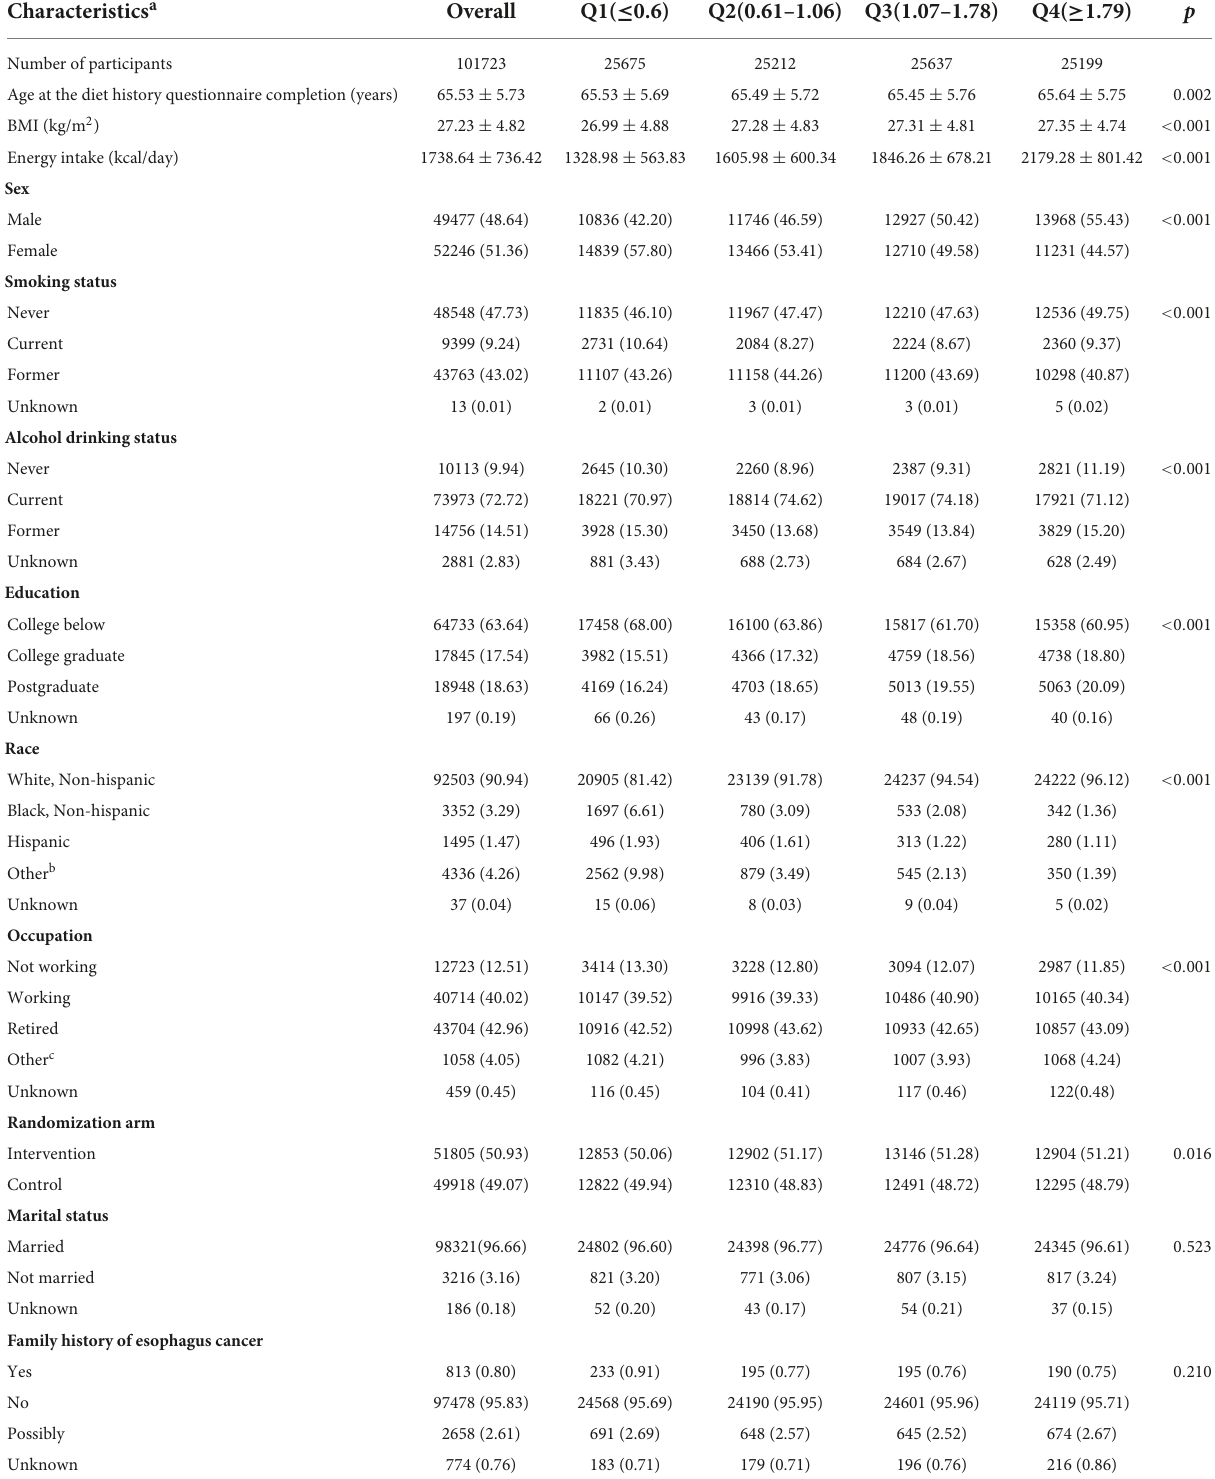
TABLE 1 Baseline characteristics of study population according to total dairy consumption in 101,723 participants. Characteristics